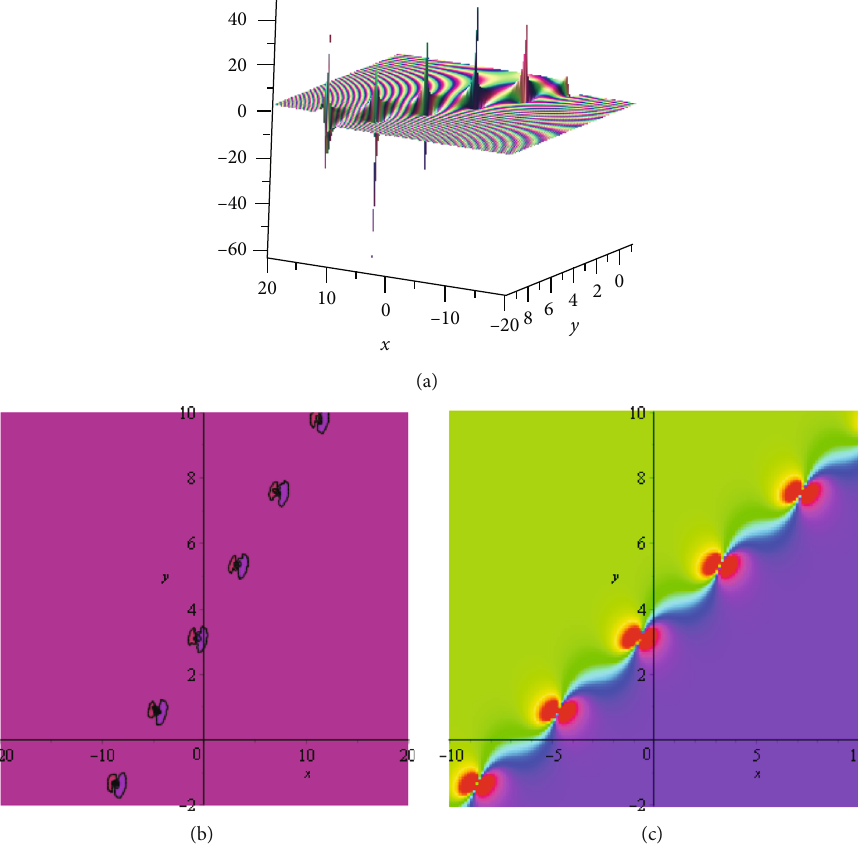
= : 5, a = 1 : 5, a = 2, a = 1, Ω = 1 : 1, Ω = 1 : 2, δ = 1, δ = 1 : 3, δ = 2 1 2 3 4 4 7 1 2 3